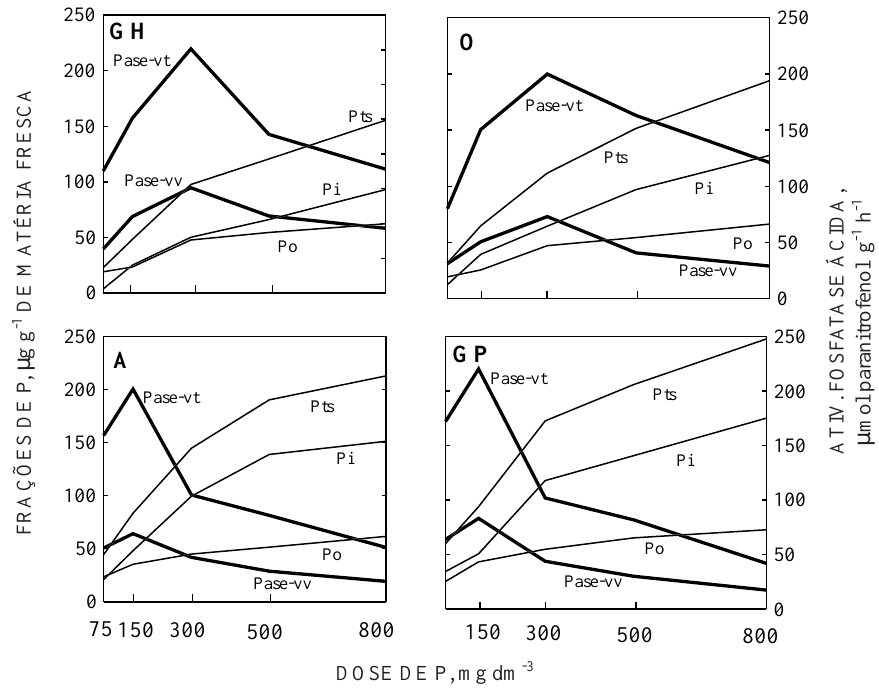
Figura 2. Fósforo total solúvel em ácido (Pts), P orgânico (Po), P inorgânico (Pi) e atividade de fosfatase ácida in vivo (Pase-vv) e in vitro (Pase-vt) nas folhas de feijoeiro cultivado nos solos Glei Húmico (GH), Orgânico, Aluvial (A) e Glei Pouco Húmico (GP), na presença de